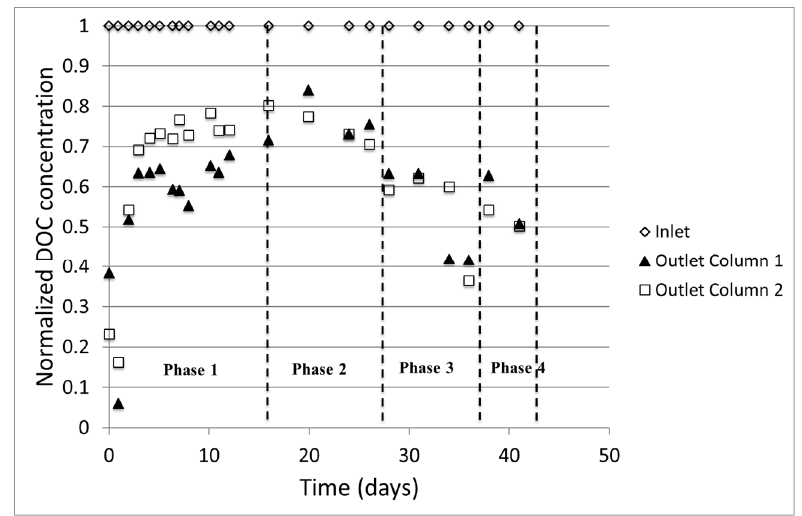
Figure 3. Normalized DOC profile at the inlet and outlet of the filters at different phases.